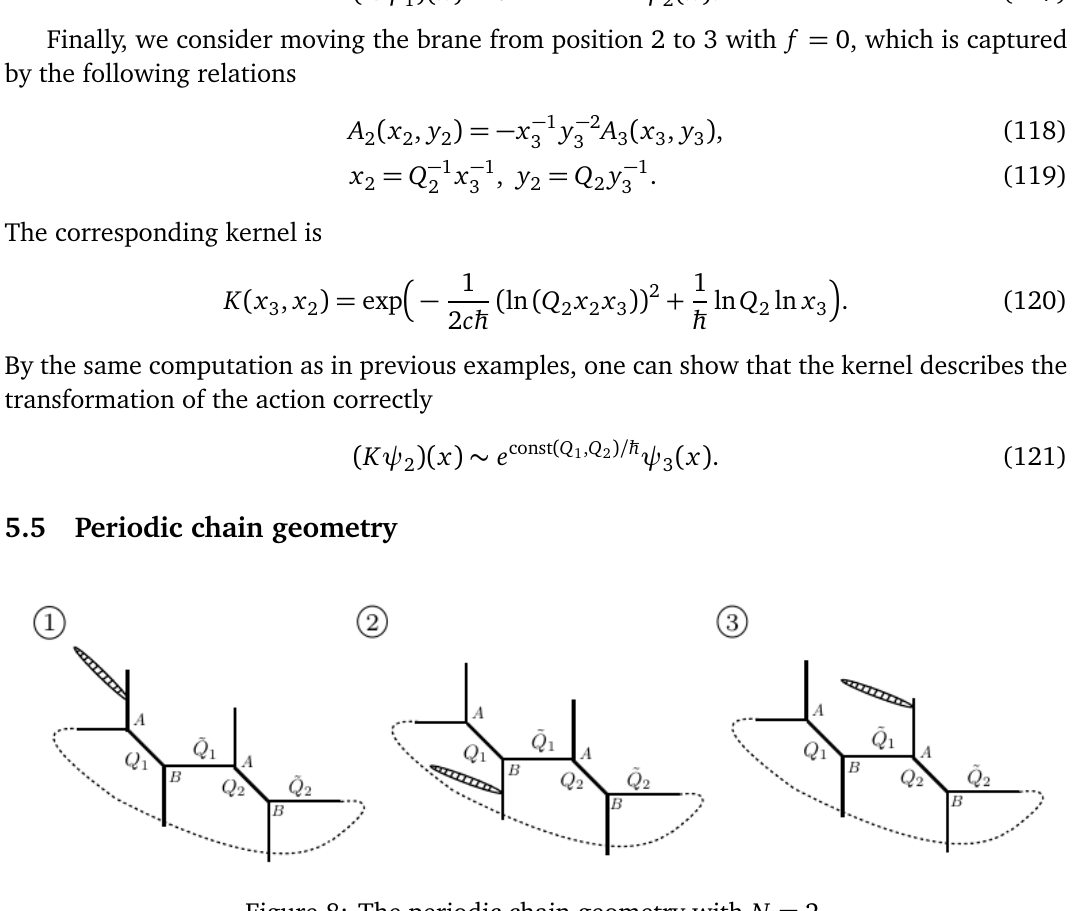
Figure 8: The periodic chain geometry with N =